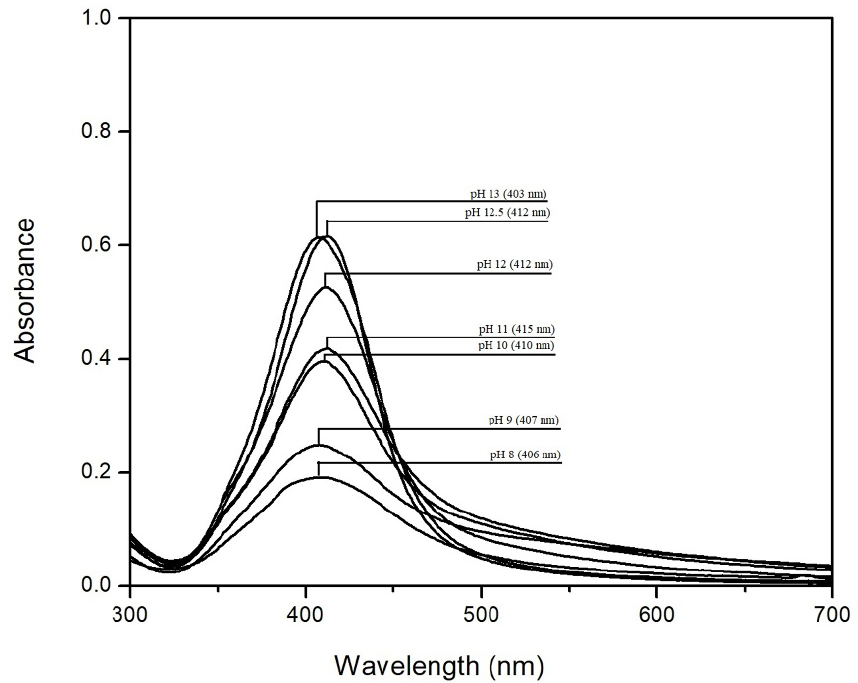
Figure 1. UV-VIS spectra recorded for prepared